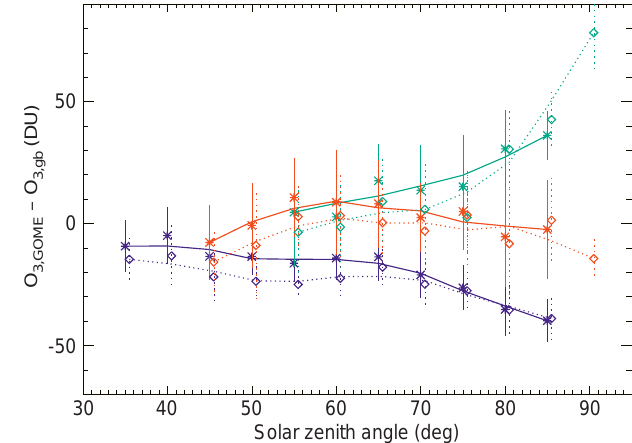
Fig. 6. Deviation of GOME total ozone from GUV values, averaged in 5-degree SZA intervals in July 1996 ( blue ), March 1997 ( green ), and April 1997 ( red ). Solid line / asterisks : forward-swath pixels, diamonds/ dotted line : back-swath pixels. Vertical bars : standard deviations of ozone deviations. SZA values for back-swath pixels are o(cid:128)set by 0.5 (cid:176) for clarity